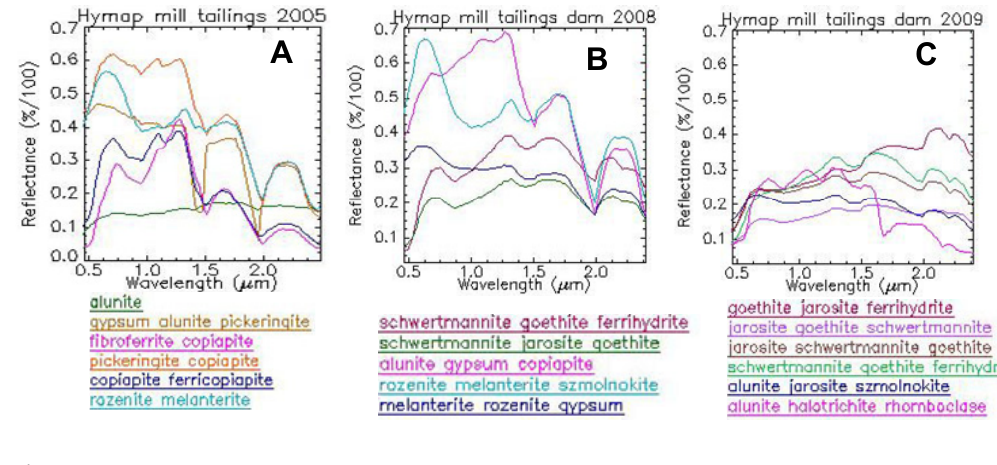
Figure 6. The mill tailings dam. Spectra from HyMap areas mapped in ( A ) June 2005, ( B ) August 2008, and ( C ) August 2009. Spectra are arranged on a precipitation and oxidation sequence. The color coding follows the trend of the key from Figure 3, but changes are made for